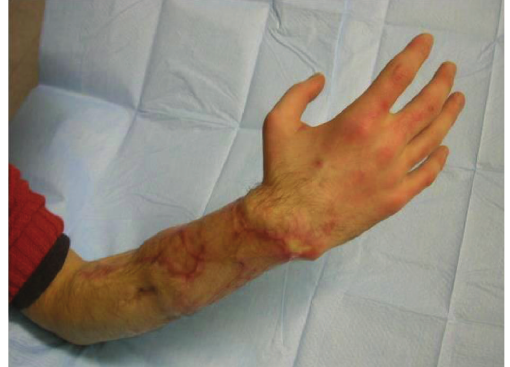
Figure 12: Patient showing a good